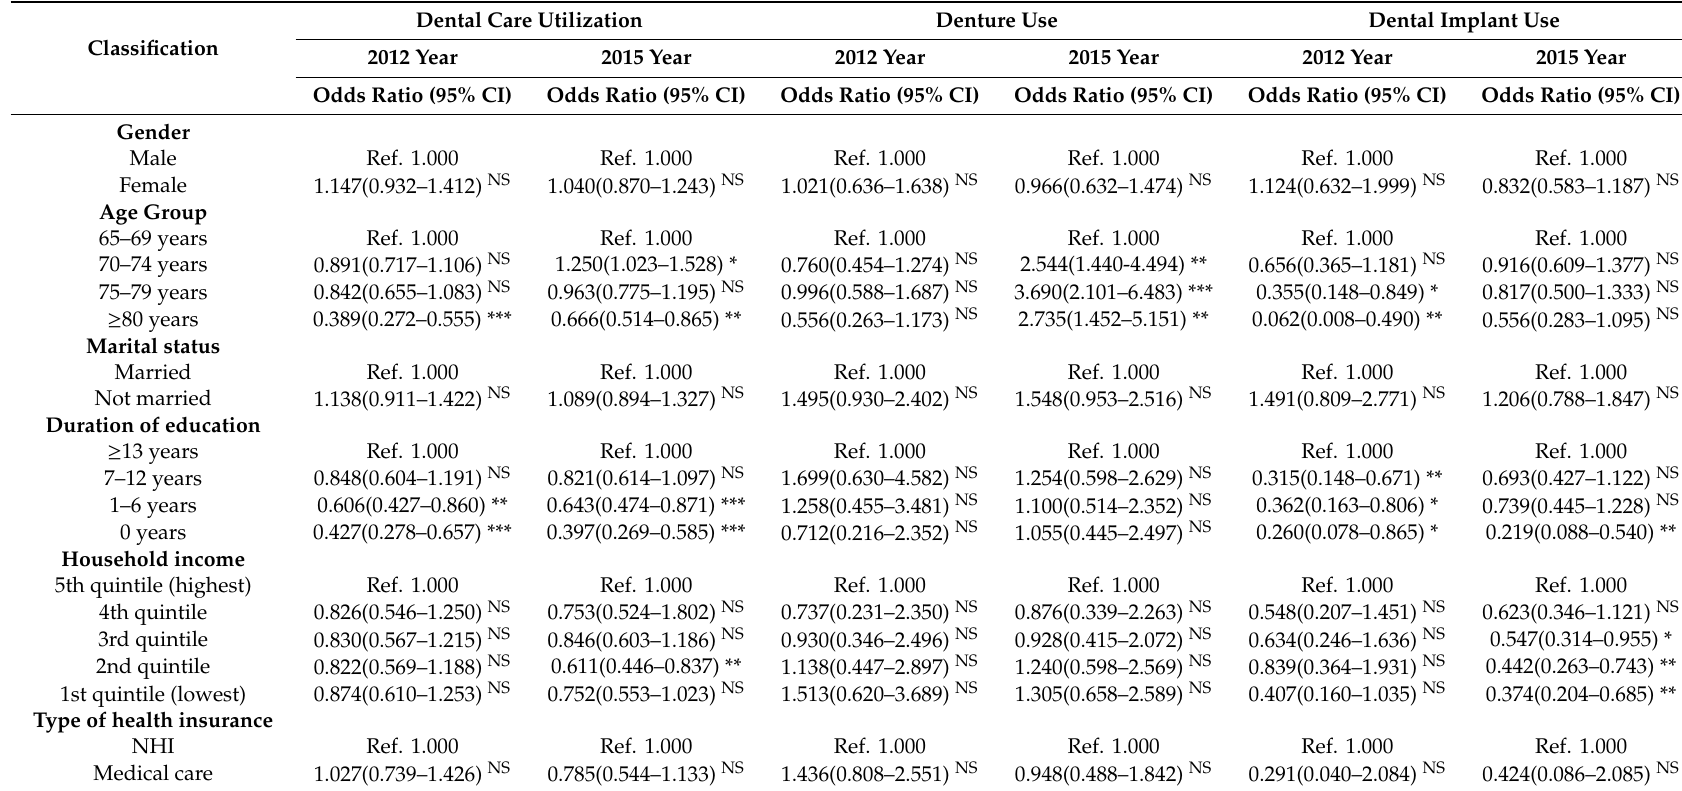
Table 2. Changes in the associations between the annual dental care utilization and sociodemographic characteristics after expanded coverage of dental prostheses for older